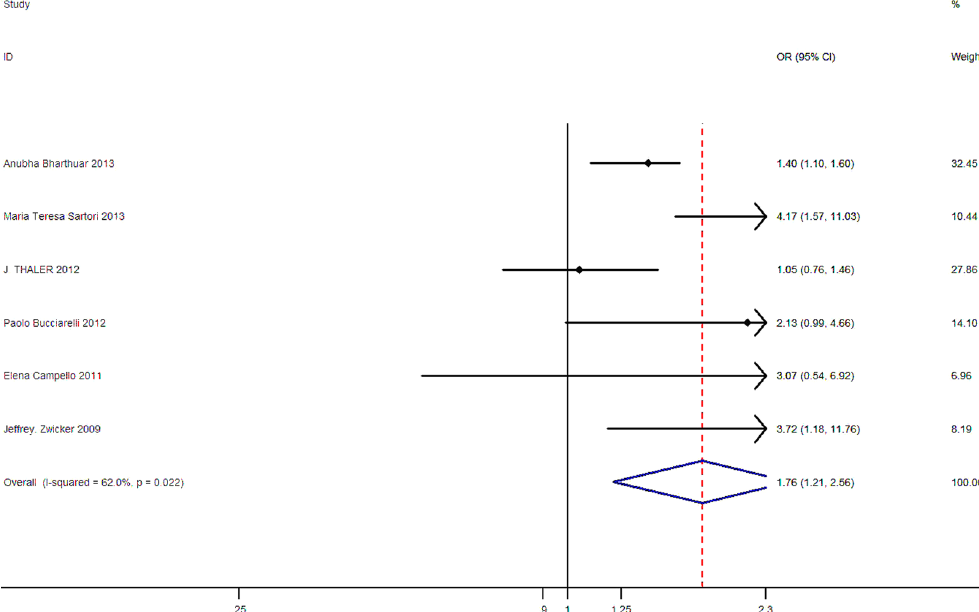
Figure 2. Forest plot of association between TF-bearing MPs and VTE risk in cancer patients, the horizontal lines represent the study-specific OR and 95% CI, respectively. The diamond indicates the pooled results of OR and 95% CI.